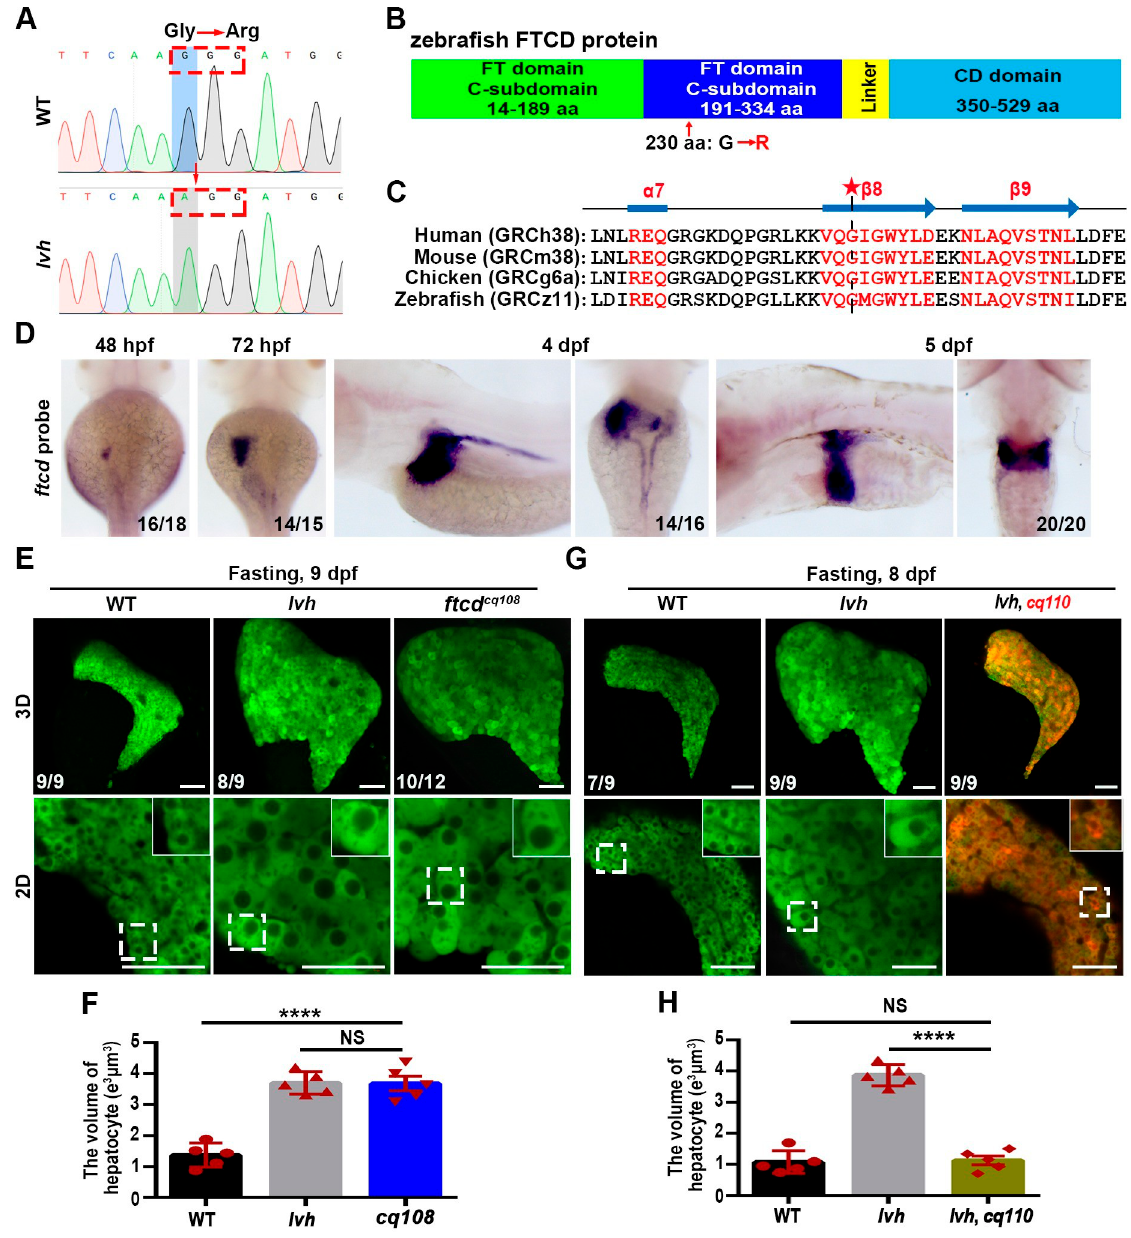
Fig 3. The hepatomegaly of lvh is caused by mutation of ftcd . (A) Sequencing of ftcd from the wild-type and lvh mutant identified a G to A point mutation, resulting in a switch from glycine to arginine at position 691. Red arrow indicates the mutation site. (B) Diagramed FTCD protein structure and the mutation in lvh at FT domain C-subdomain. (C) A conserved β 8 motif of FTCD in zebrafish and its homologous proteins in humans, mouse and chicken. Asterisk indicates the site of mutated amino acid in lvh . (D) WISH images showing ftcd expressions at 48 hpf, 72 hpf, 4 dpf, and 5 dpf. (E) 3D confocal projection and 2D single-optical section images showing the liver of wild-type, lvh and, ftcd cq108 at 9 dpf. Higher magnification images of single hepatocytes are displayed. (F) Unpaired Student’s t -test for single hepatocyte volume in the wild-type (n = 5), lvh (n = 5) and cq 108 (n = 5). (G) 3D confocal projection and 2D single-optical section images showing the liver of WT, lvh and lvh under cq 110 background at 8 dpf. Higher magnification images of single hepatocytes are displayed. (H) Unpaired Student’s t- test for single hepatocyte volume in the wild-type (n = 5), lvh (n = 5) and lvh under cq 110 (n = 5). Asterisks indicate statistical significance. ���� P < 0.0001. Data are represented as mean ± SD. WT, wild-type. Scale bars, 50 μ m.